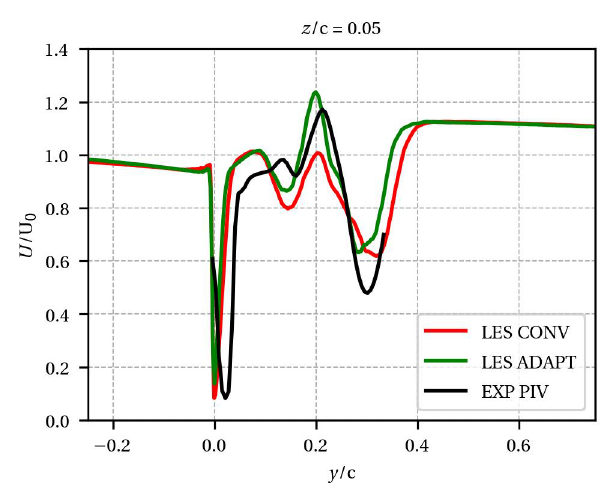
Figure 12. Mean velocity profile of U at x /c = 0.01 and z /c = 0.05.